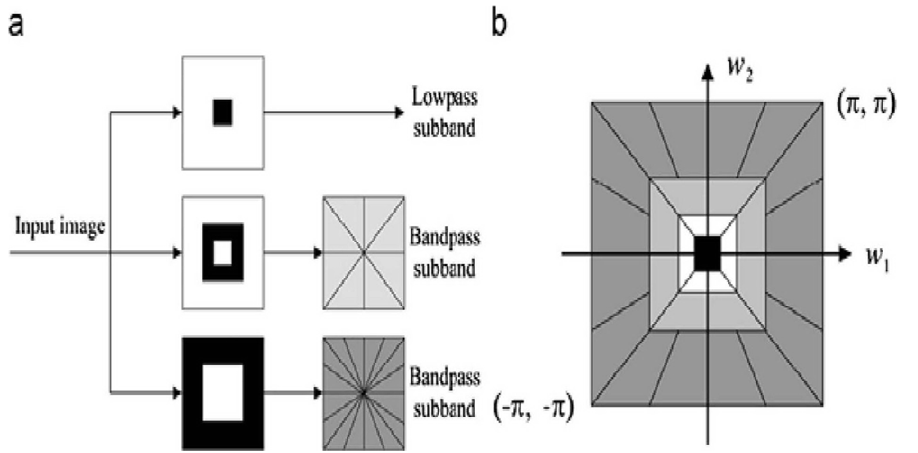
Figure 1. Two-level nonsubsampled contourlet transform decomposition. (a) NSFB structure that implements the NSCT (b) The obtained Frequency